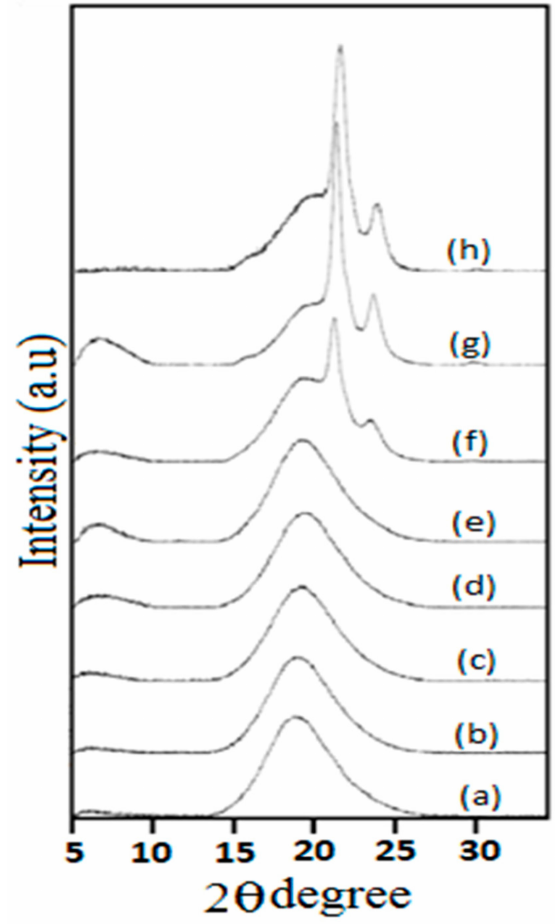
Figure 3. X-ray diffractograms of PUEs sorted by varying molecular weight of PCLs (ascending